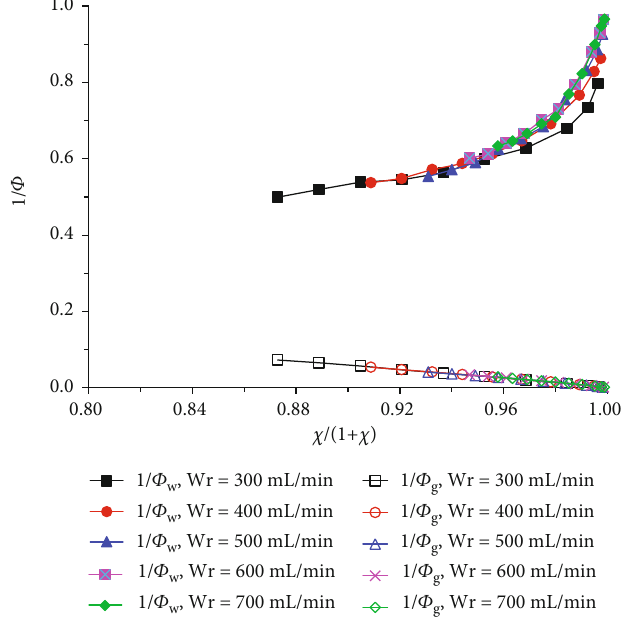
Figure 12: The relationship between Φ